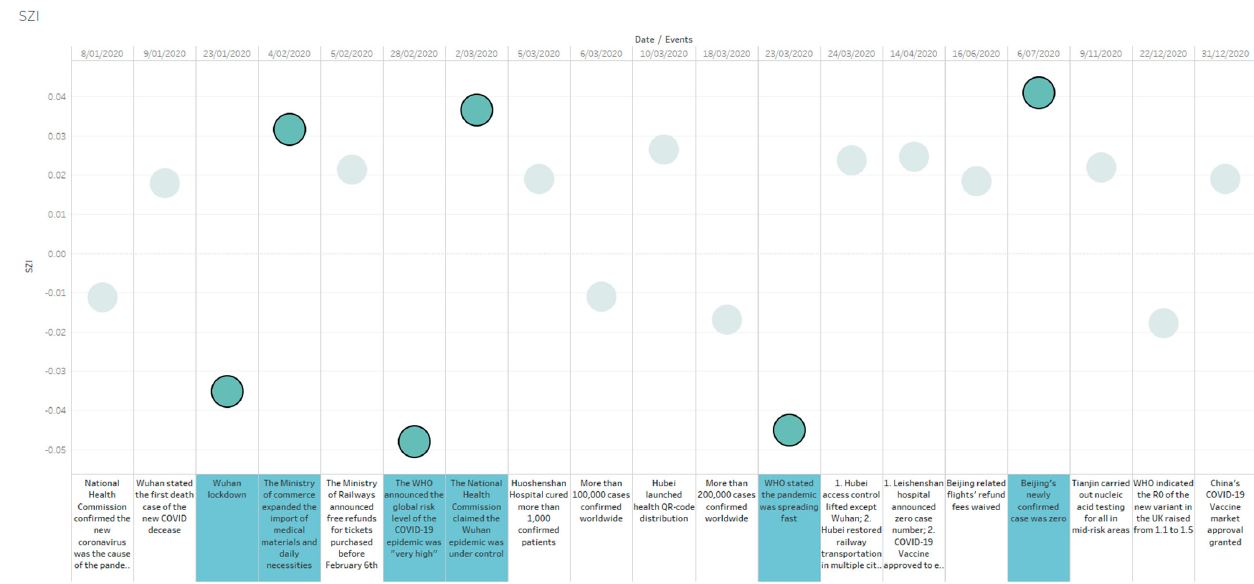
Appl. Sci. 2021 , 11 , x FOR PEER REVIEW Figure 5. SZI’s trends on relevant social events. Figure 5. SZI’s trends on relevant social events.